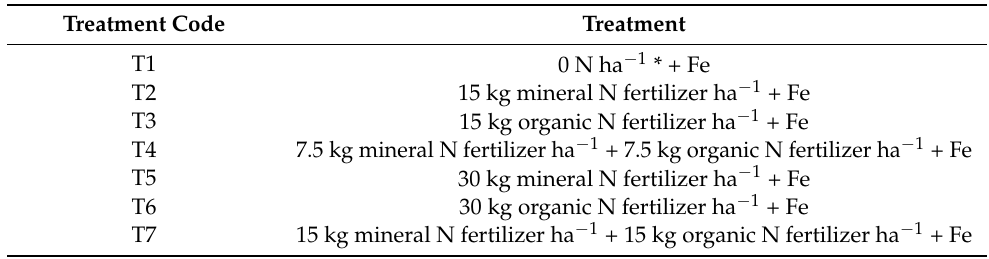
Table 3. Treatments applied to determine the influence of optimal N supply on cowpea grain yield and Fe